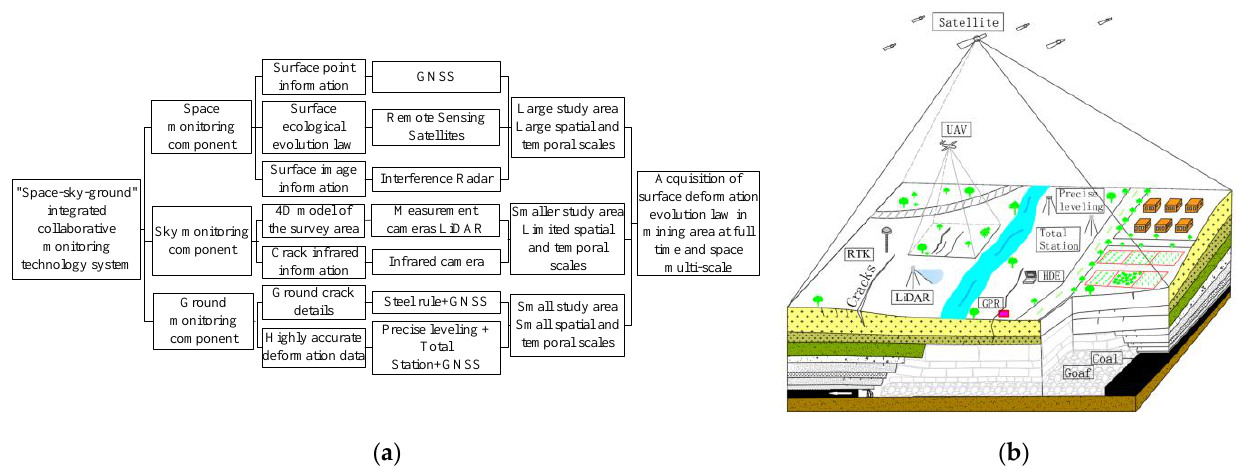
The abbreviation in Table 1: CORS (Continuously Operating Reference Stations), D-InSAR (Differential Interfer- ometry Synthetic Aperture Radar), SBAS-InSAR (Small Baseline Subset Interferometry Synthetic Aperture Radar), RTK (Real Time Kinematic).